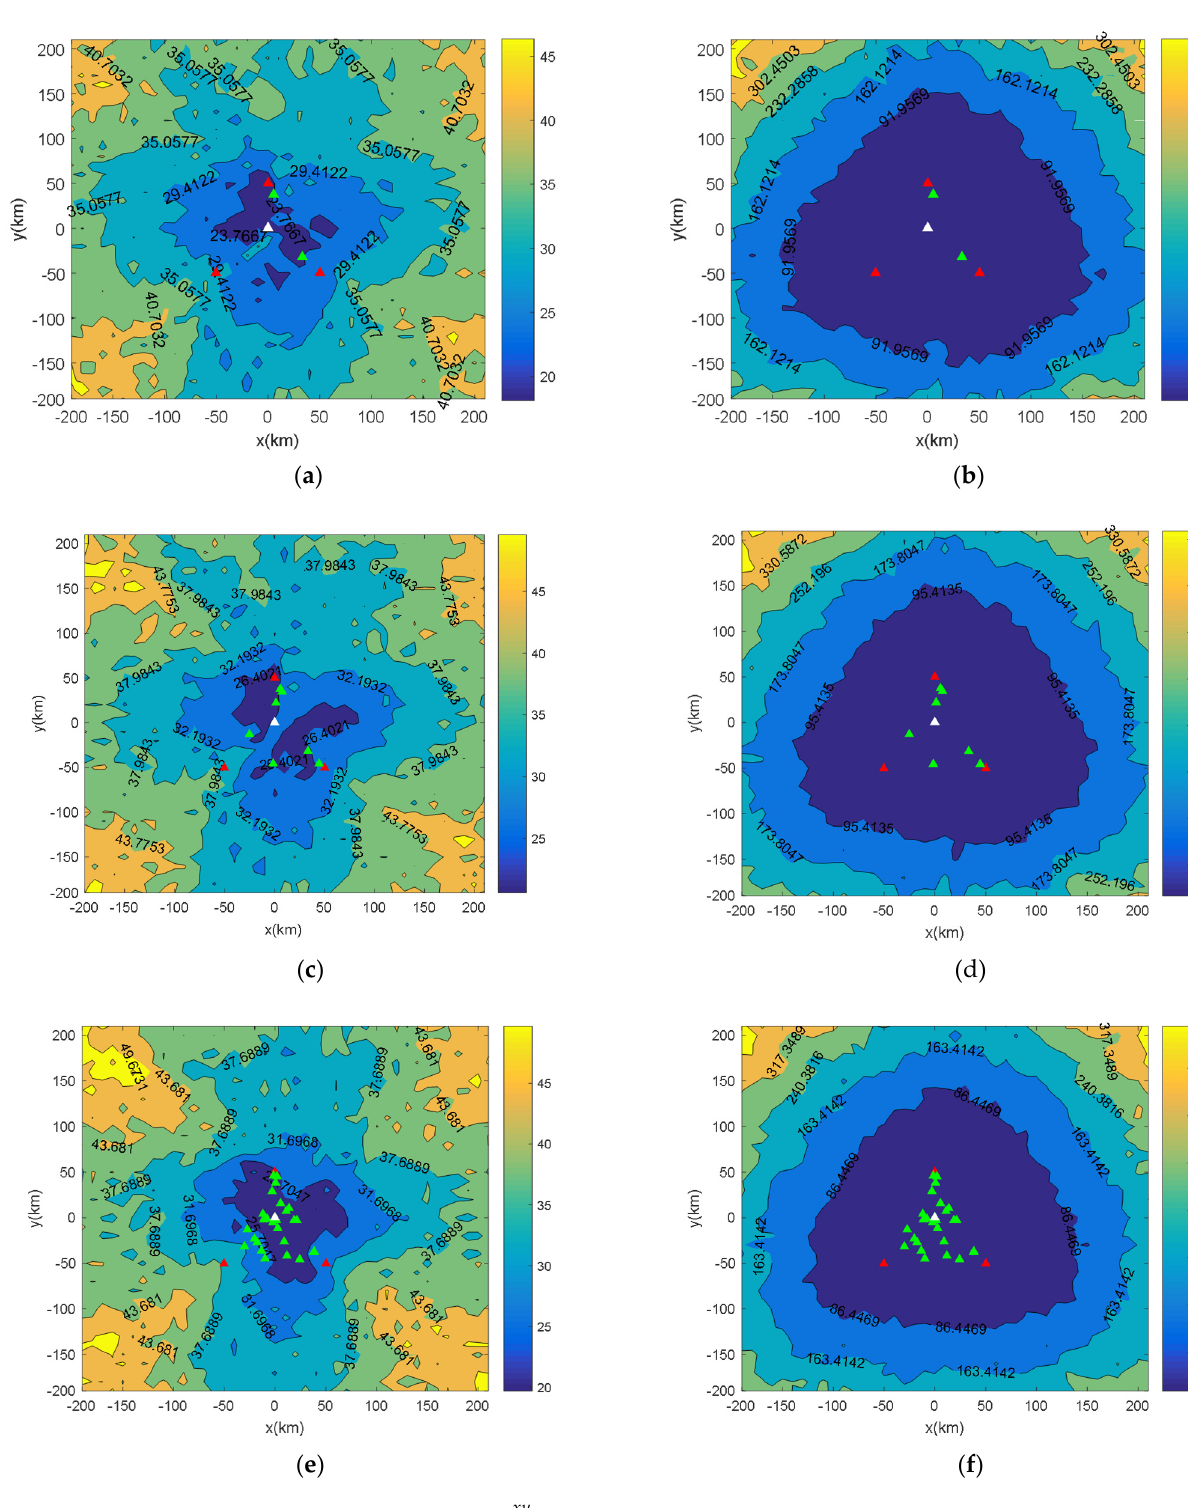
Figure 10. ( a ) RMSE xy under five receivers; ( b ) RMSE z under five receivers; ( c ) RMSE xy under 10 receivers; ( d ) RMSE z under 10 receivers; ( e ) RMSE xy under 30 receivers; ( f ) RMSE z under 30 receivers. The location errors under the 10 × 10 × 10 m grid step. The white triangle shows locations at the origin, and the three red triangles form a triangle that covers the others, whose color is